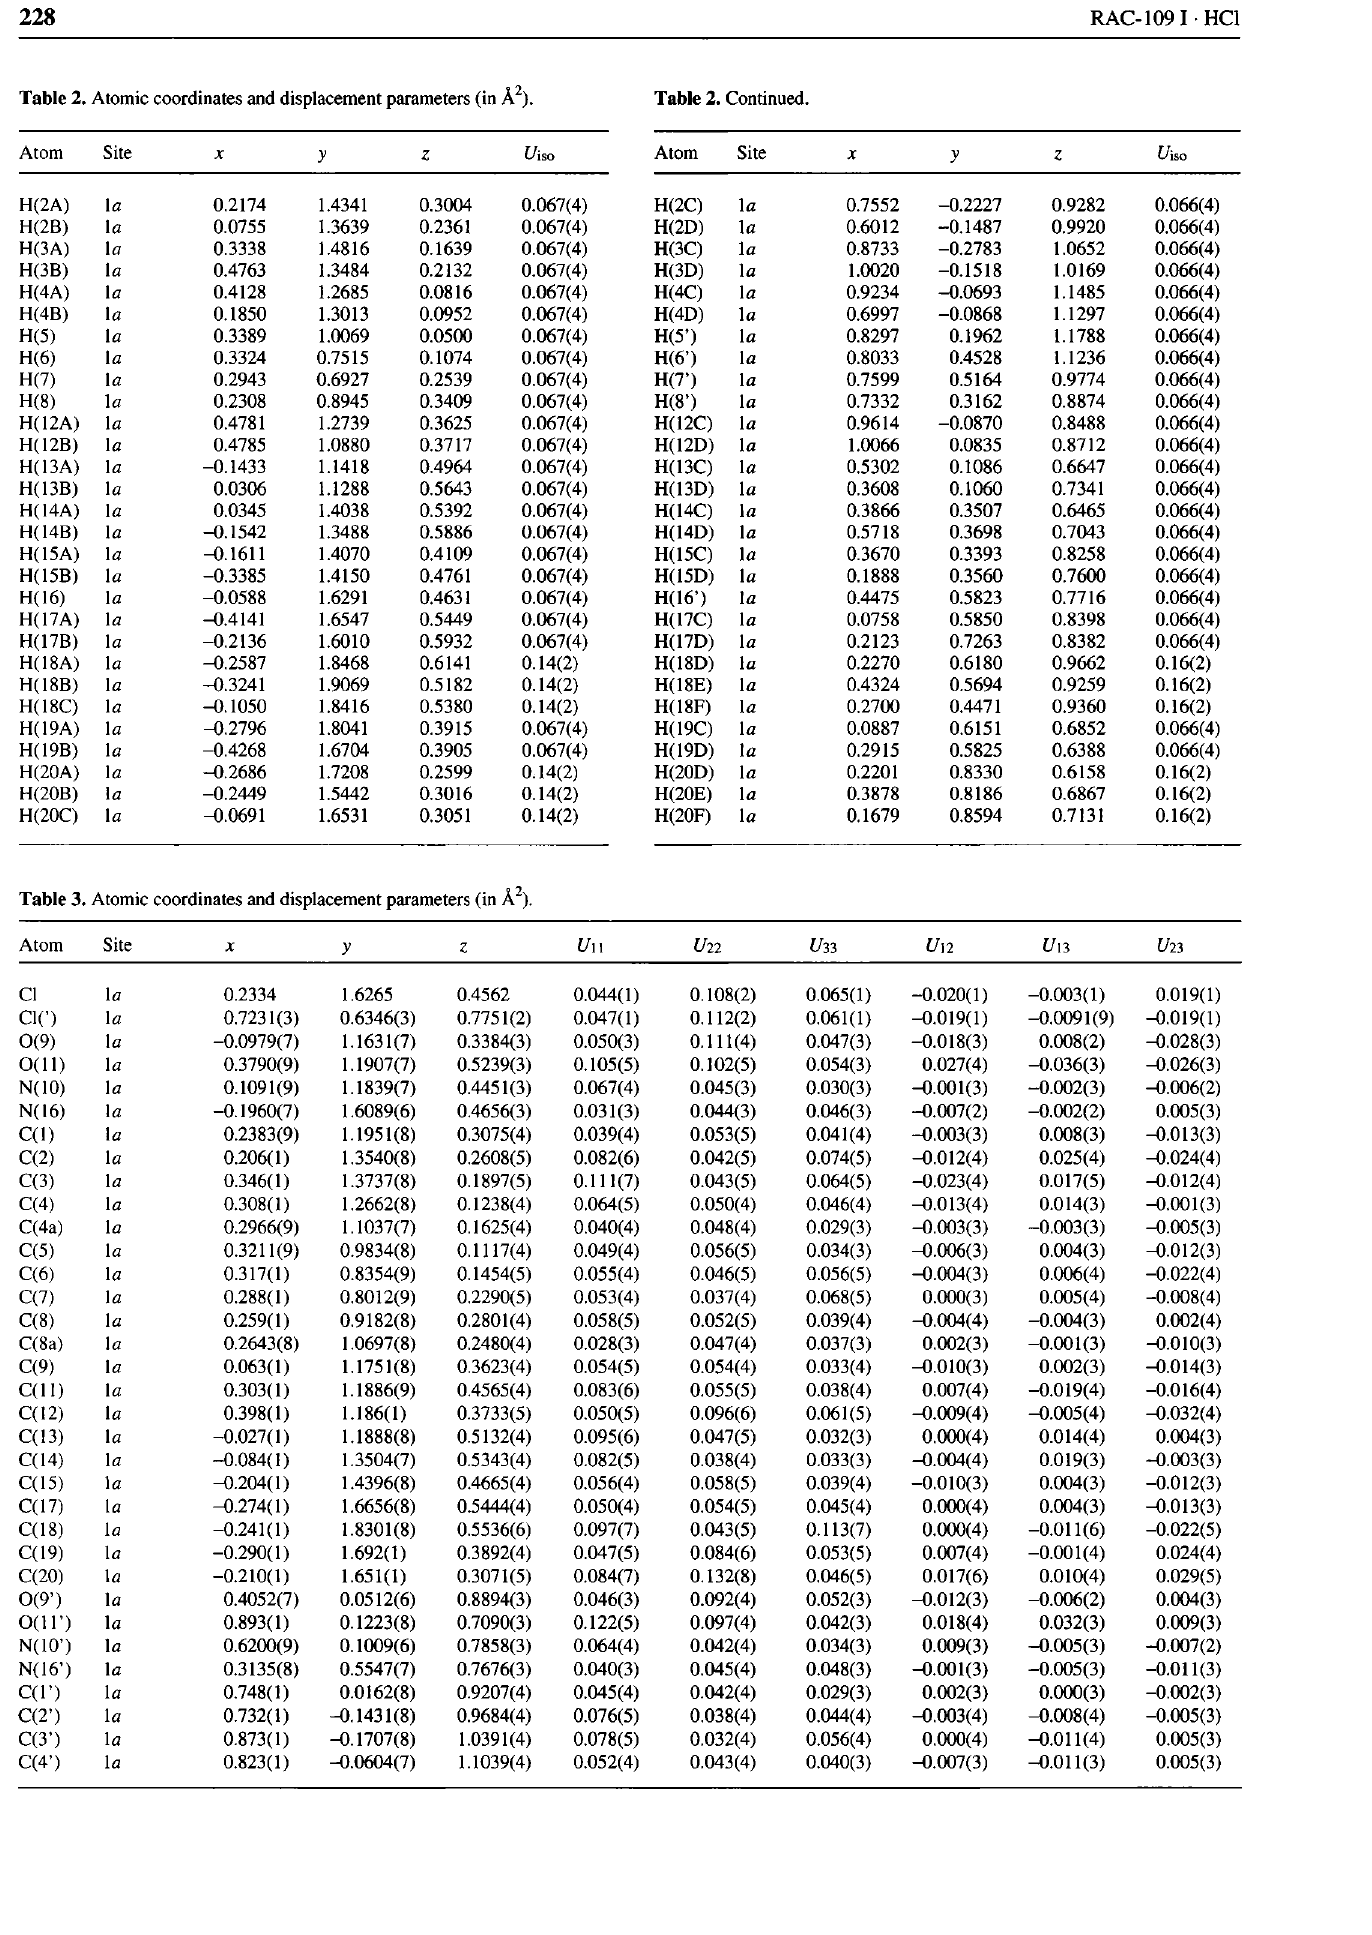
Table 3. Atomic coordinates and displacement parameters (in Ä 2